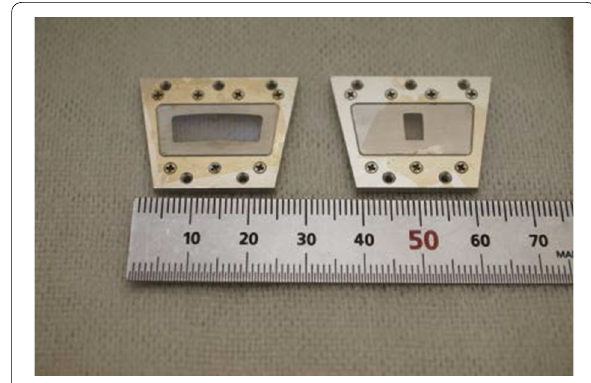
Fig. 7 Carbon foil holders for the normal sectors (left) and narrow sectors (right), with open areas of 12.5° and 2.5° in the azimuth, respectively